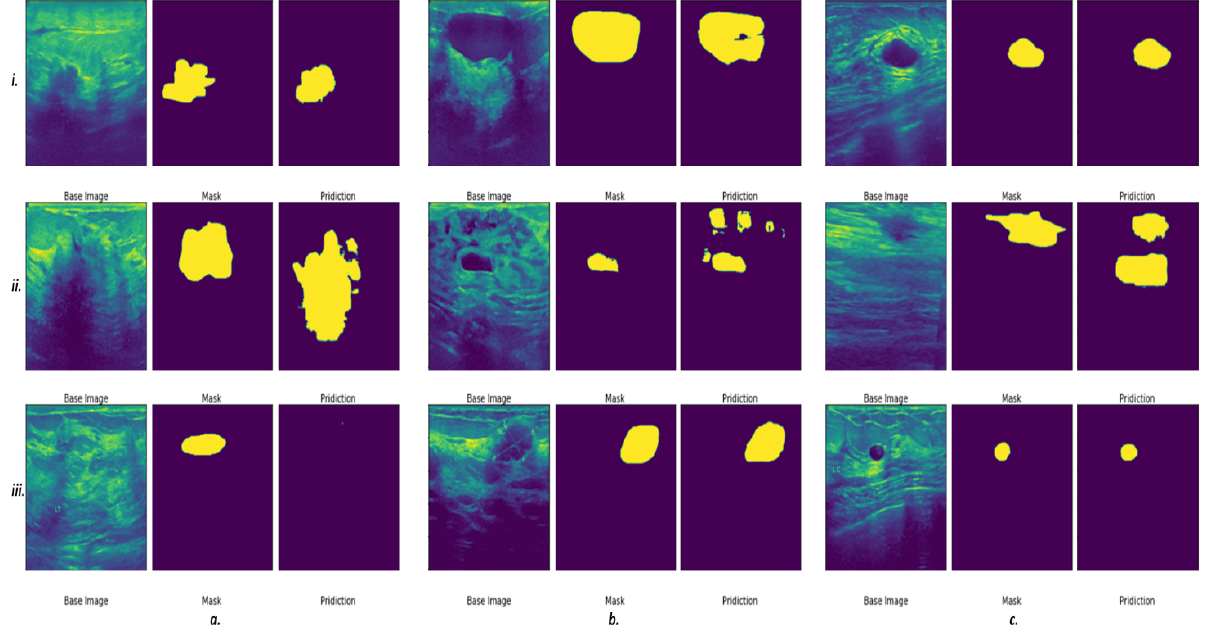
Figure 4. Preliminary results indicate a promising outcome of automated breast lesion segmenta- tion. Some examples of successful ( a.i , c.i , b.iii , c.iii ), semi-successful ( b.i , a.ii , b.ii , c.ii ) and unsuccess- ful segmentations ( a.iii ) are